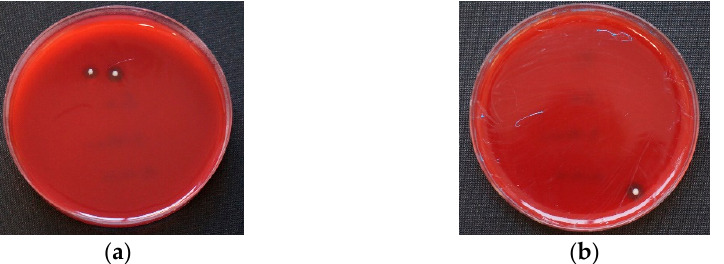
Figure 4. Examples of Staphylococcus aureus on Columbia agar. ( a ) Polyether Adhesive (PA) after 15 min incubation; ( b ) Polyether Contact Tray Adhesive (PCTA) after 30 min incubation. In Universal Adhesive (UA) and Fix Adhesive (FA), no colonies could be detected at both times. Table 1. Agar probes of Staphylococcus aureus and Candida albicans up to 30 min incubation. All other strains showed no viable bacteria or fungi at any time.